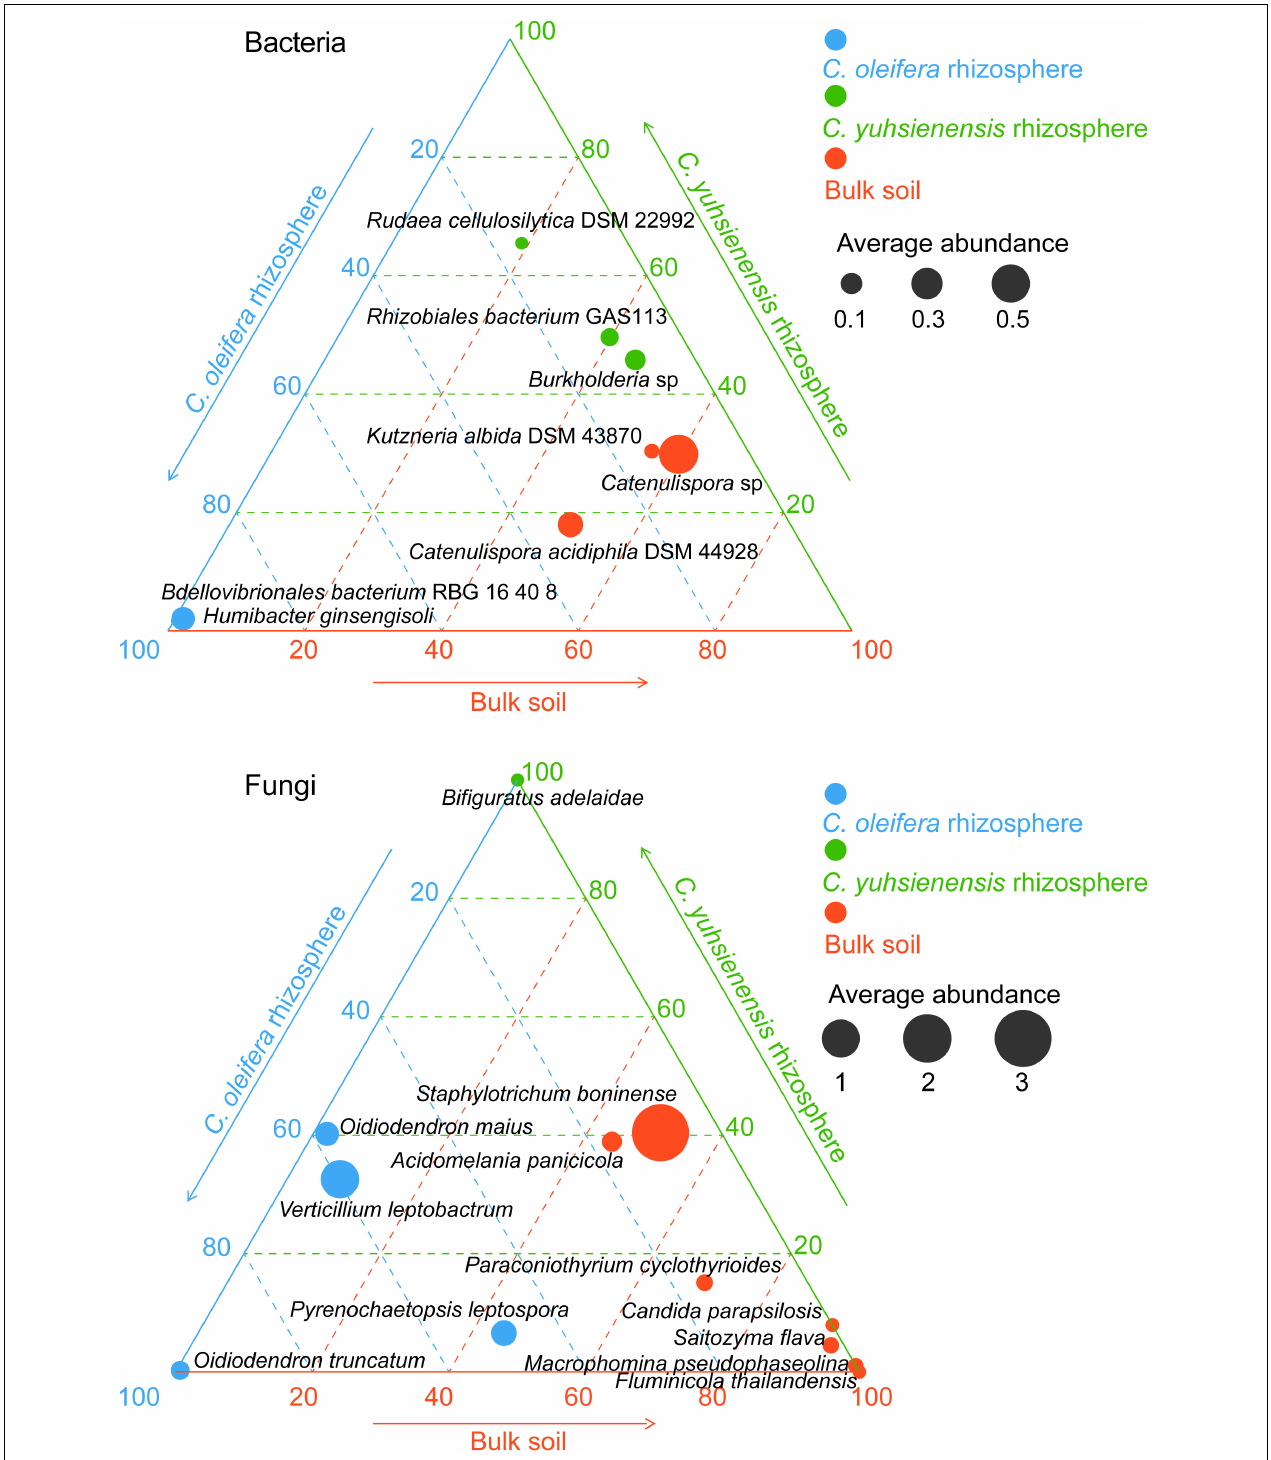
FIGURE 3 | Distribution of specific bacterial and fungal species across disease-susceptible C. oleifera rhizosphere (blue), disease-resistant C. yuhsienensis rhizosphere (green), and bulk soil (red) in ternary plots. The circle size and position indicates the average relative abundance (%) and the ratio of relative abundance of each microbial group with C. oleifera rhizosphere, C. yuhsienensis rhizosphere, and bulk soil (conducted using Kruskal–Wallis analysis, p < 0.05), respectively, N = 12.